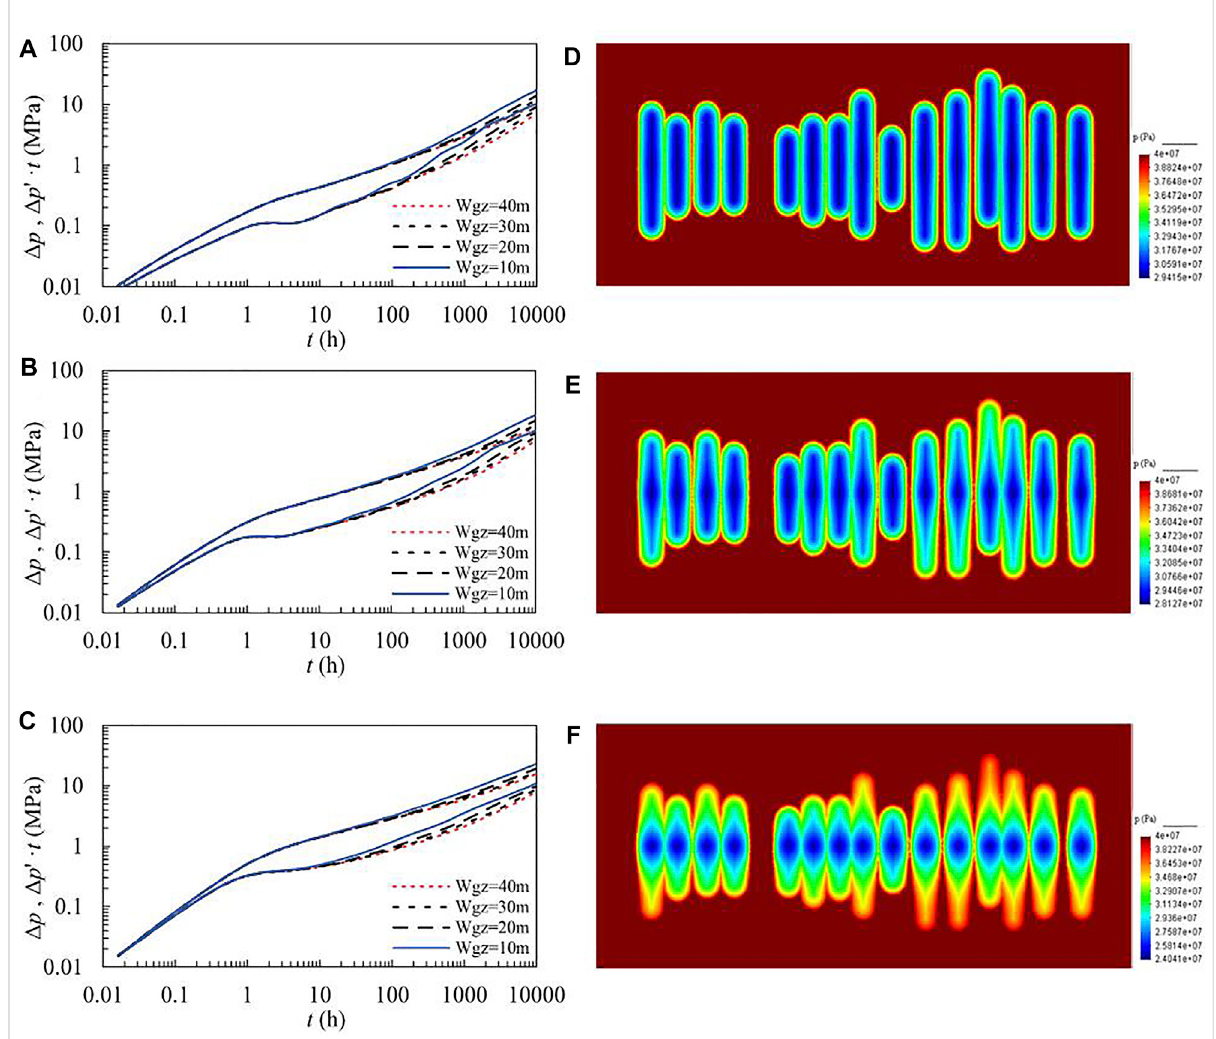
FIGURE 2 Log – log plot under different W gz conditions and formation pressure distribution. (A) K w = 0.5 μ m 2 m; (B) K w = 0.1 μ m 2 m; (C) K w = 0.02 μ m 2 m; (D)